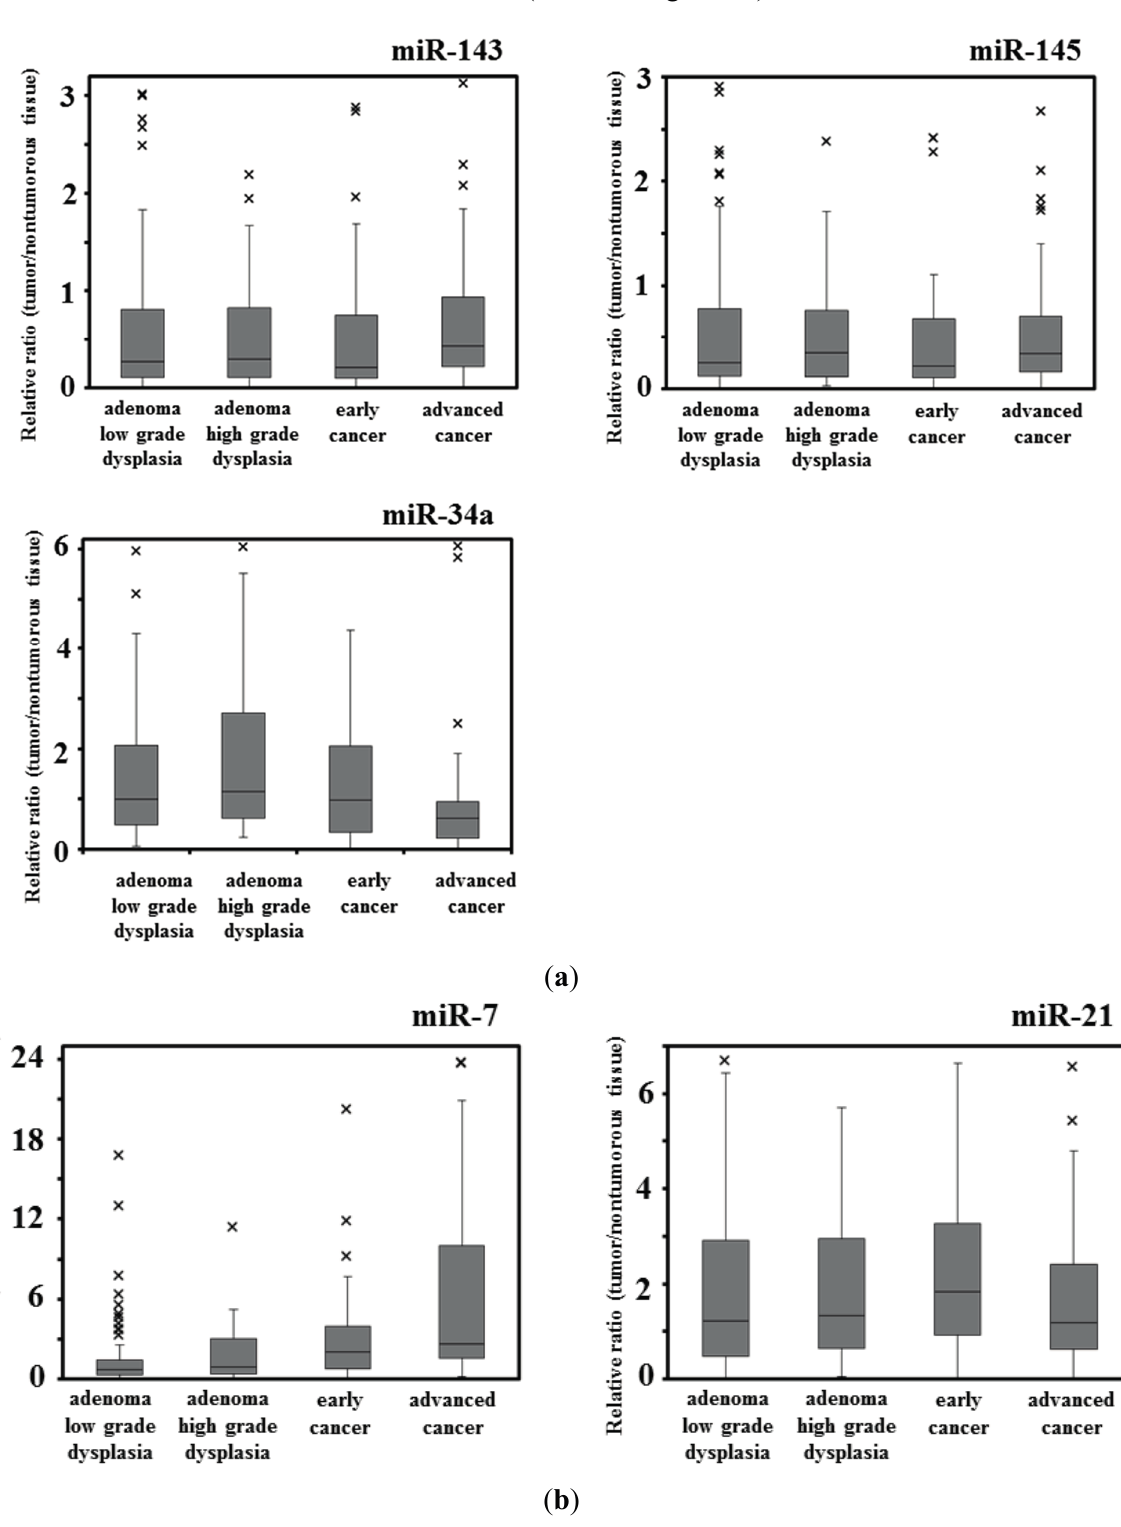
Figure 2. Box-and-whisker plots of miRNA expression in colorectal tumors. ( a ) Down-regulated miRNAs (miR-143, -145, and -34a); and ( b ) Up-regulated miRNAs (miR-7 and -21). ×: outlier of miRNA